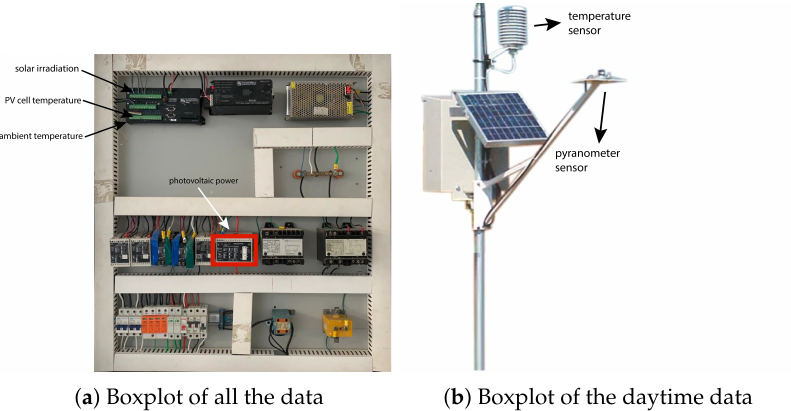
Figure 1. Data acquisition infrastructure.( a ) Instrumentation panel and data acquisition unit of the